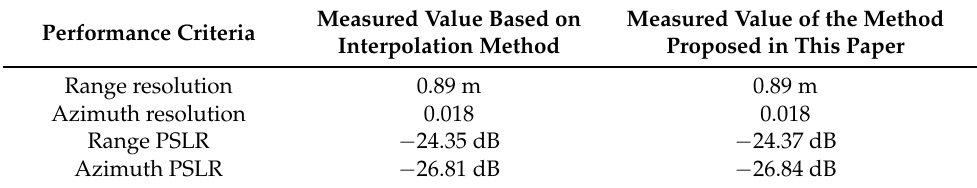
Figure 19. Target analysis of imaging results based on the method proposed in this paper. ( a ) Range profile. ( b ) Azimuthal profile. Table 4. Point target performance